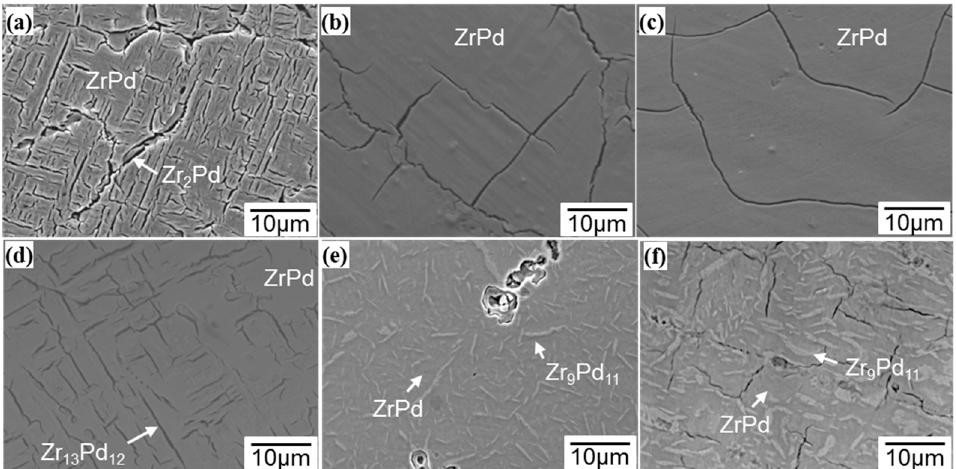
Figure 4. ( a – c ) SEM images of Zr-49, 50, and 51 atom % Pd alloys aged at 1273 K for 3.6 ks, respectively. Zr-49 atom % Pd alloy consist of both the monoclinic ZrPd martensitic phase showing the surface relief and Zr 2 Pd phase, as shown in ( a ). On the other hand, each Zr-50 and 51 atom % Pd alloy is composed of only ZrPd martensitic phase, as shown in ( b , c ), respectively. ( d – f ) SEM images of Zr-49, 50, and 51 atom % Pd alloys aged at 1048 K for 90 ks, respectively. Zr-49 atom % Pd alloy is composed of the Zr 13 Pd 12 precipitate in the ZrPd martensitic matrix, as shown in ( d ). Zr-50 and 51 atom % Pd alloy consist of two phases, that is, the Zr 9 Pd 11 precipitates in ZrPd martensitic matrix, as shown in ( e , f ), respectively.